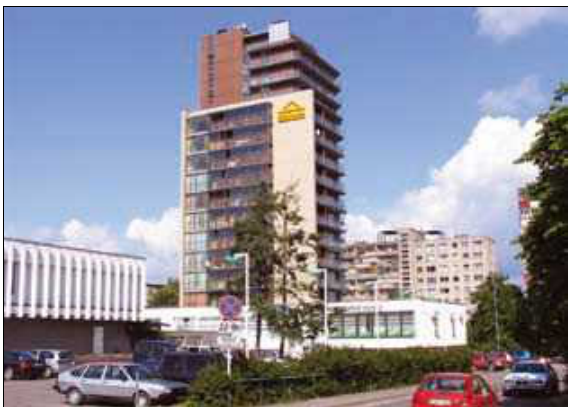
Žirmūnų g. (archit. G. balkė, D. Striu­kas, V. Stu­pak, Fig. 12. high-rise block of flats in a­ntakalnis st. a­rch. G. balkė, D. Striu­kas, V. Stu­pak, e. Žarkovskienė, G. tu­naitis, L. karmaza, V. Silevičiu­s